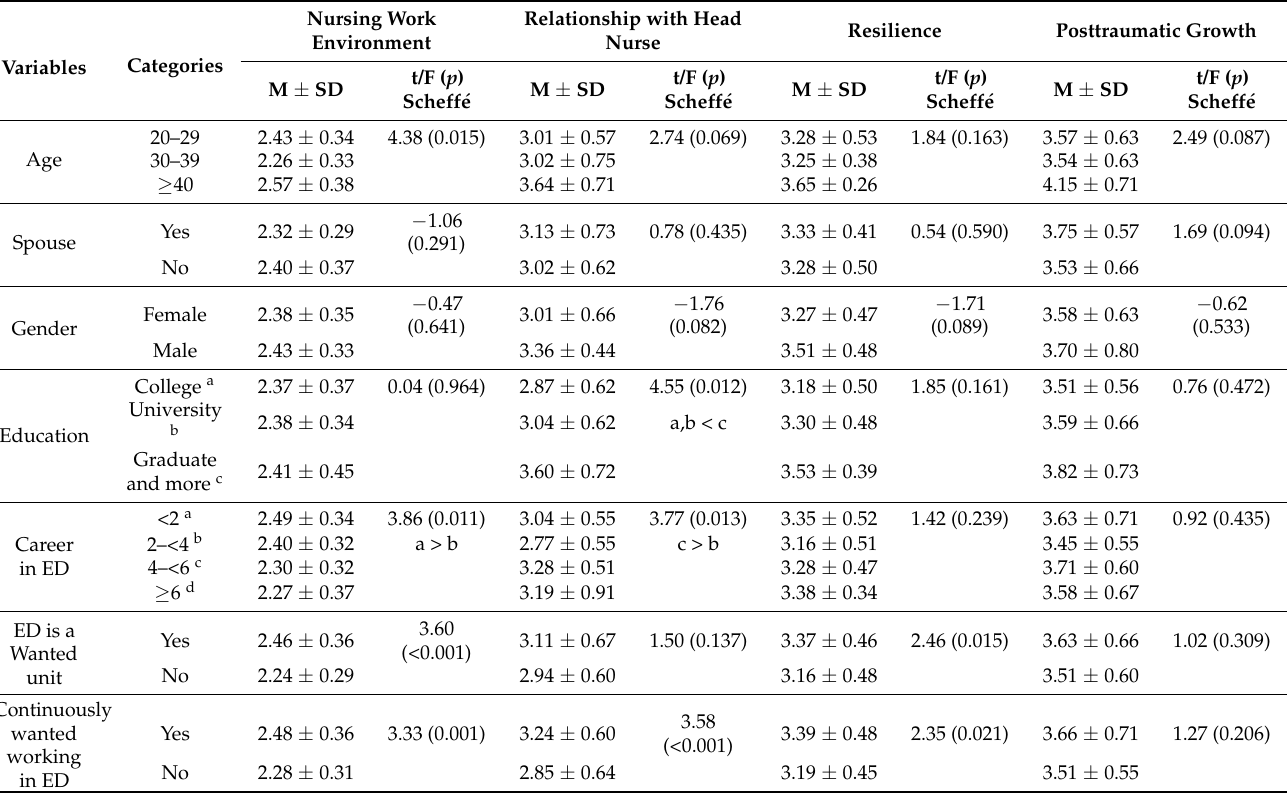
Table 3. Differences in the work environment, relationship with the head nurse, resilience, and posttraumatic growth according to the general